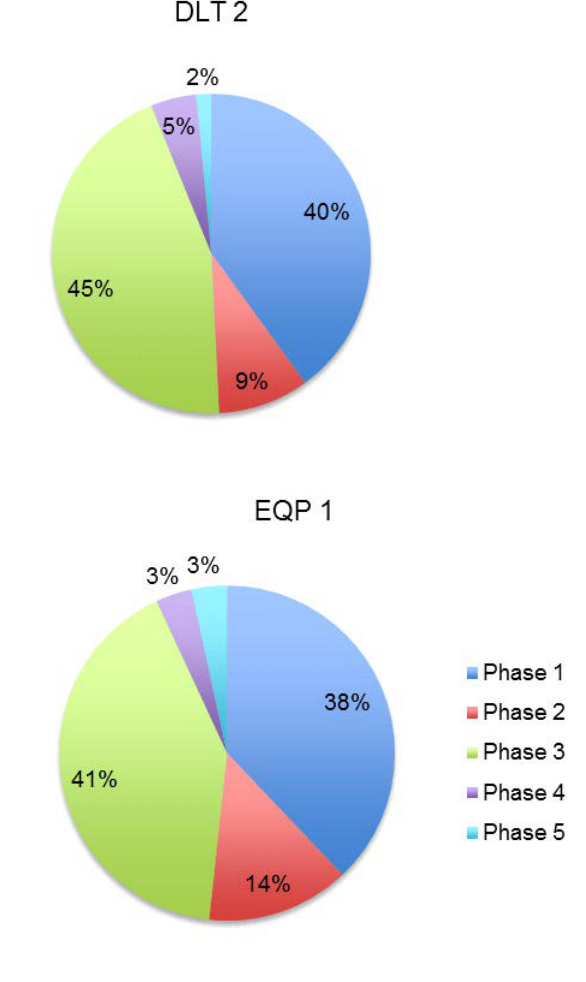
Figure 3. Highest phase of knowledge construction reached by discussion